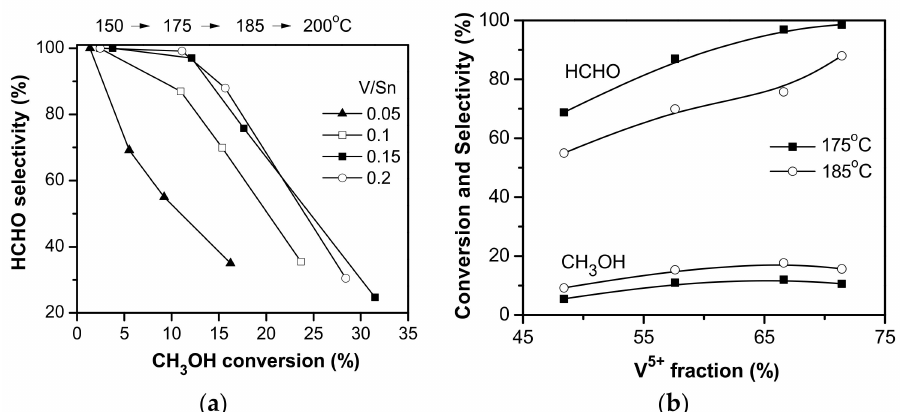
Figure 33. ( a ) V-Sn catalyst activity and selectivity for MeOH oxidation to FA at temperatures 150–200 ◦ C [208]. ( b ) MeOH conversion and selectivity towards CH 2 O as function of V 5+ fraction measured by XPS at the reaction temperatures 175 ◦ C and 185 ◦ C. Reprinted with permission from [208] © 2011 The American Ceramic Society.